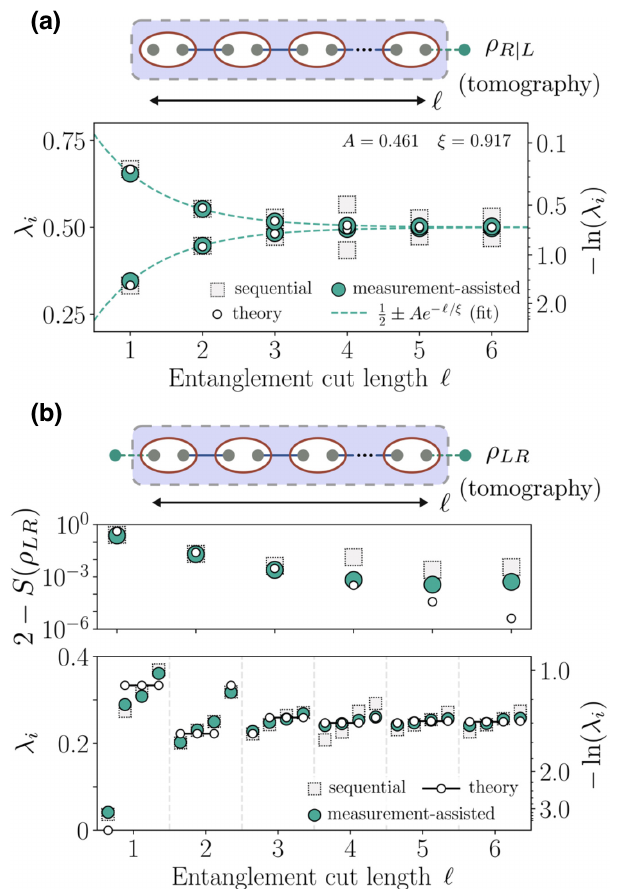
FIG. 7. The entanglement spectrum for varying entanglement cut lengths (cid:5) , experimentally determined via state tomography of memory qubits. The left-hand axes display eigenvalues λ i of (a) ρ ρ R | L and (b) LR , while the right-hand axes show the correspond- ing entanglement spectrum − ln (λ i ) . As in Fig. 6, the uncertain- ties are computed via bootstrap methods and found to fall within the displayed markers. (a) The entanglement spectrum estimated from the state of the right qubit given the measured state of the left, ρ R | L . Such a measurement emulates the entanglement cut of a semi-infinite spin chain, in analogy to the holographic measurement scheme presented in Ref. [45]. The dashed green ± Ae − (cid:5)/ξ to the experi- line displays a least-squares best fit of 1 2 mentally measured eigenvalues λ i for the state prepared via our measurement-assisted approach, with ξ = 0.9172 ( 4 ) —in excel- lent agreement with the exact correlation length of the AKLT state, ξ AKLT = 1 / ln ( 3 ) ≈ 0.9102. (b) The experimentally mea- sured entanglement spectrum (bottom) and the entanglement entropy (top), extracted from tomographic measurement of both memory qubits ( ρ LR ). This measurement corresponds to a bulk length- (cid:5) entanglement cut of an infinite AKLT chain, expected to (exponentially quickly) converge to a fourfold degenerate entanglement spectrum and entropy S (ρ LR ) = 2 for increasing (cid:5)